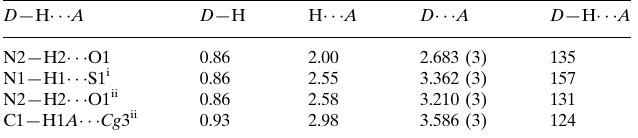
Hydrogen-bond geometry (A˚ , (cid:1)